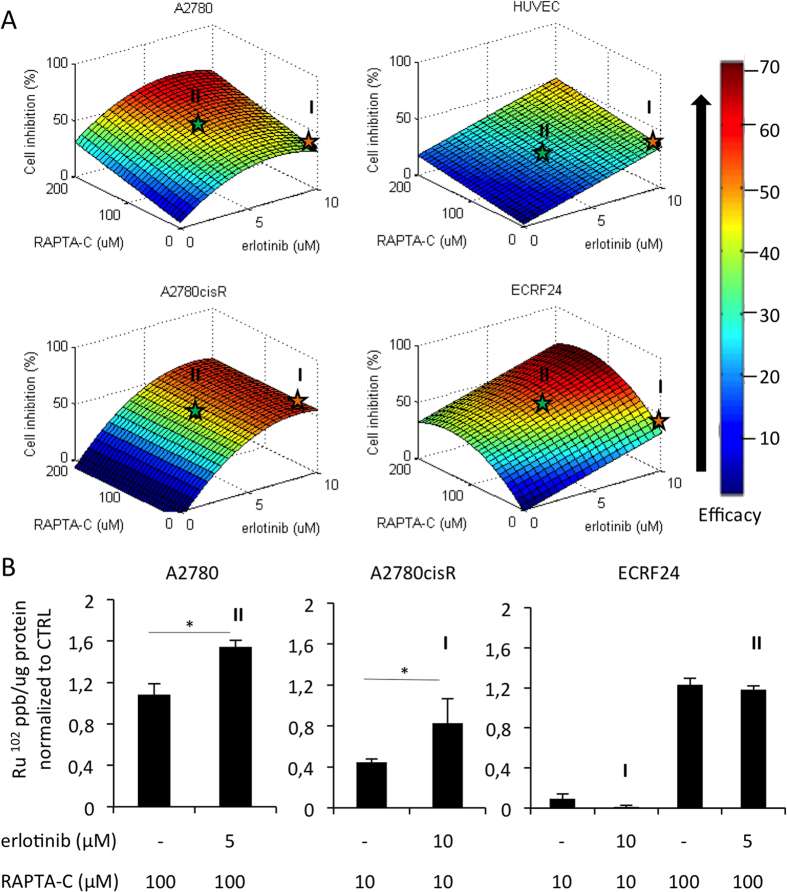
Response surfaces of ovarian cancer- and endothelial cell viability inhibition with respect to varying doses of erlotinib/RAPTA-C in combination treatments and cellular uptake of Ru in ovarian cancer cells.(A) Images show a visual representation of the effect, in terms of cell viability inhibition, of systematically varying the drug concentrations comprising erlotinib and RAPTA-C combinations. A range is shown from low efficacy (blue) to high efficacy (red). The orange star represents combination I; erlotinib/RAPTA-C (10/10 μM) and the green star represents combination II; erlotinib/RAPTA-C (5/100 μM). These dose-ratios were selected for translation to in vivo experiments. The input data used to generate the response surfaces are shown in Fig. 1A and Supplementary Figure 1. (B) Cellular uptake of Ru in each cell line for the optimal combination identified in cell proliferation assays. Values represent the mean Ru102 signal parts per billion (ppb) normalized to the protein content (per μg of protein) of each sample from one experiment performed in triplicate with error bars representing the SEM. Significance is indicated for combination treatment vs. the RAPTA-C single drug treatment group (*P = 0.028 and 0.045 in A2780 and A2780cisR cells, respectively; *P < 0.05 and **P < 0.01).